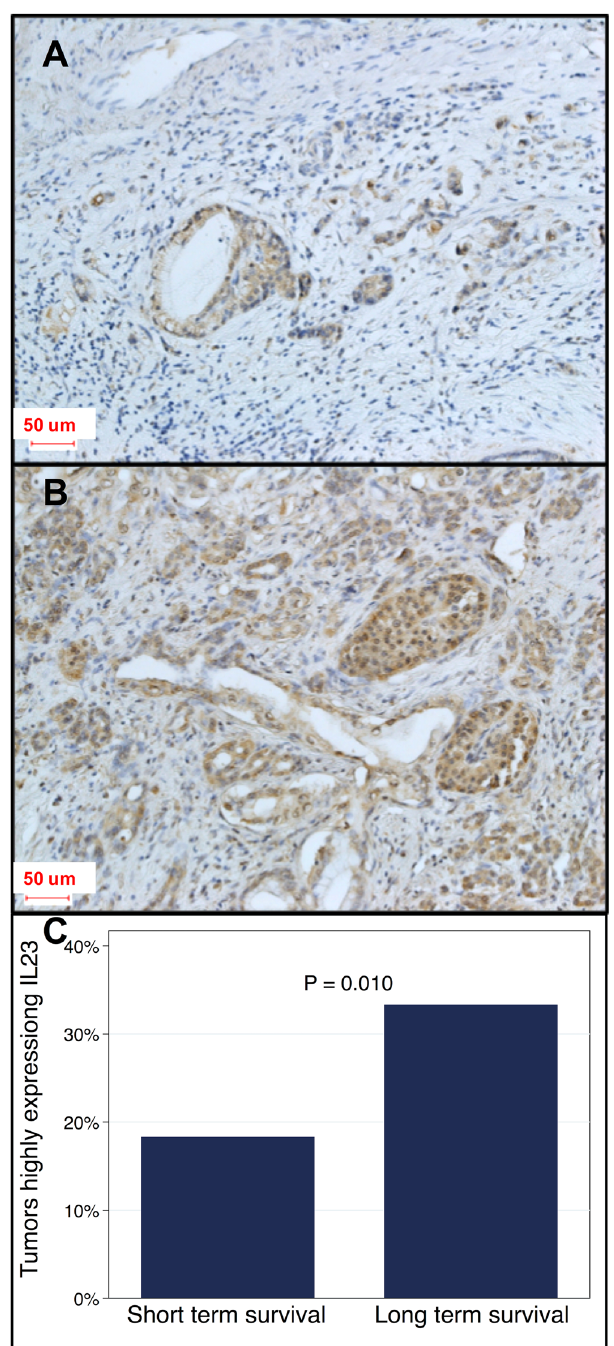
Figure 1. IL23 protein expression in patient tumor specimens. Immunohistochemistry of IL23 from tumors in patients with short-term survivors ( A ) were more likely to have low IL23 expression compared to long-term survivors which had higher IL23 expression ( B , OR = 0.48, P = 0.019). Quantification of IL23 from patients in panel A and B. Tumors from long-term survivors were more likely to highly express IL23 ( C , P =